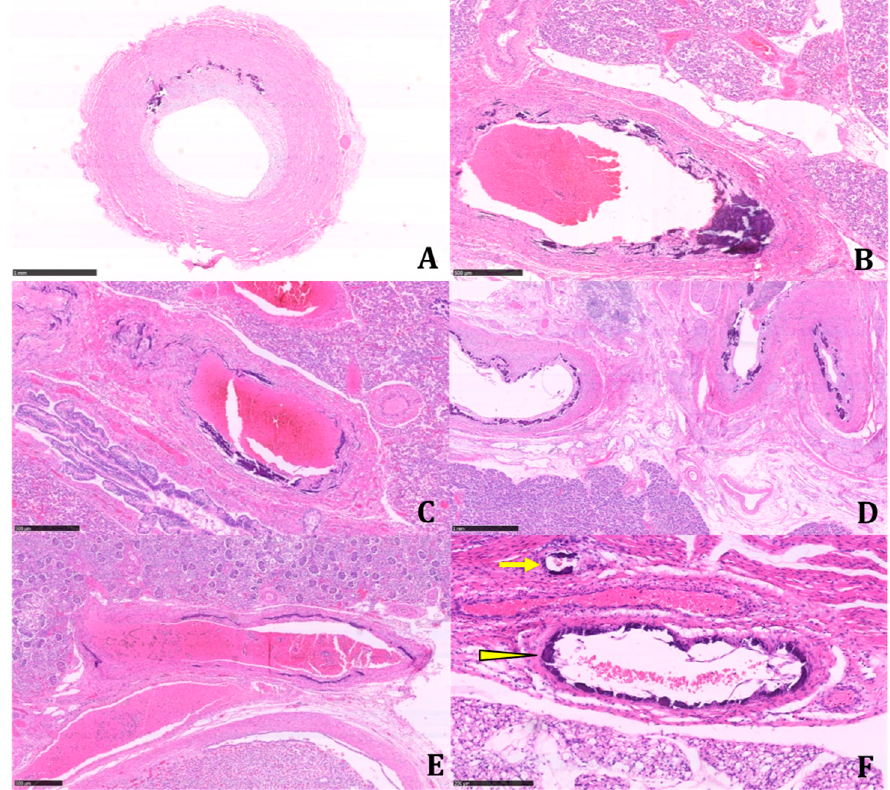
Figure 2. Systemic involvement of large arterial vessels; evidence of calcified vessels next to others histologically not involved. This demonstrates a heterogeneous vascular involvement in the same anatomical site. ( A ) Aorta (H&E, Hematoxylin and eosin; 2.91×). ( B , C ) Large hilar and intraparenchymal pulmonary vessels (H&E; 4.84× and 5.15×). ( D ) Retroperitoneal peripancreatic arteries (H&E; 2.22×). ( E ) Renal hilar artery (H&E; 3.79×). ( F ) Retroperitoneal artery of medium caliber (arrowhead) and small caliber (arrow) (H&E; 12.6×). All histological preparations were digitized and photographed with Nanozoomer 360, Hamamatsu. Scale bars: A: 1 mm; B: 500 µm; C: 500 µm; D: 1 mm; E: 500 µm; F: 250 µm).